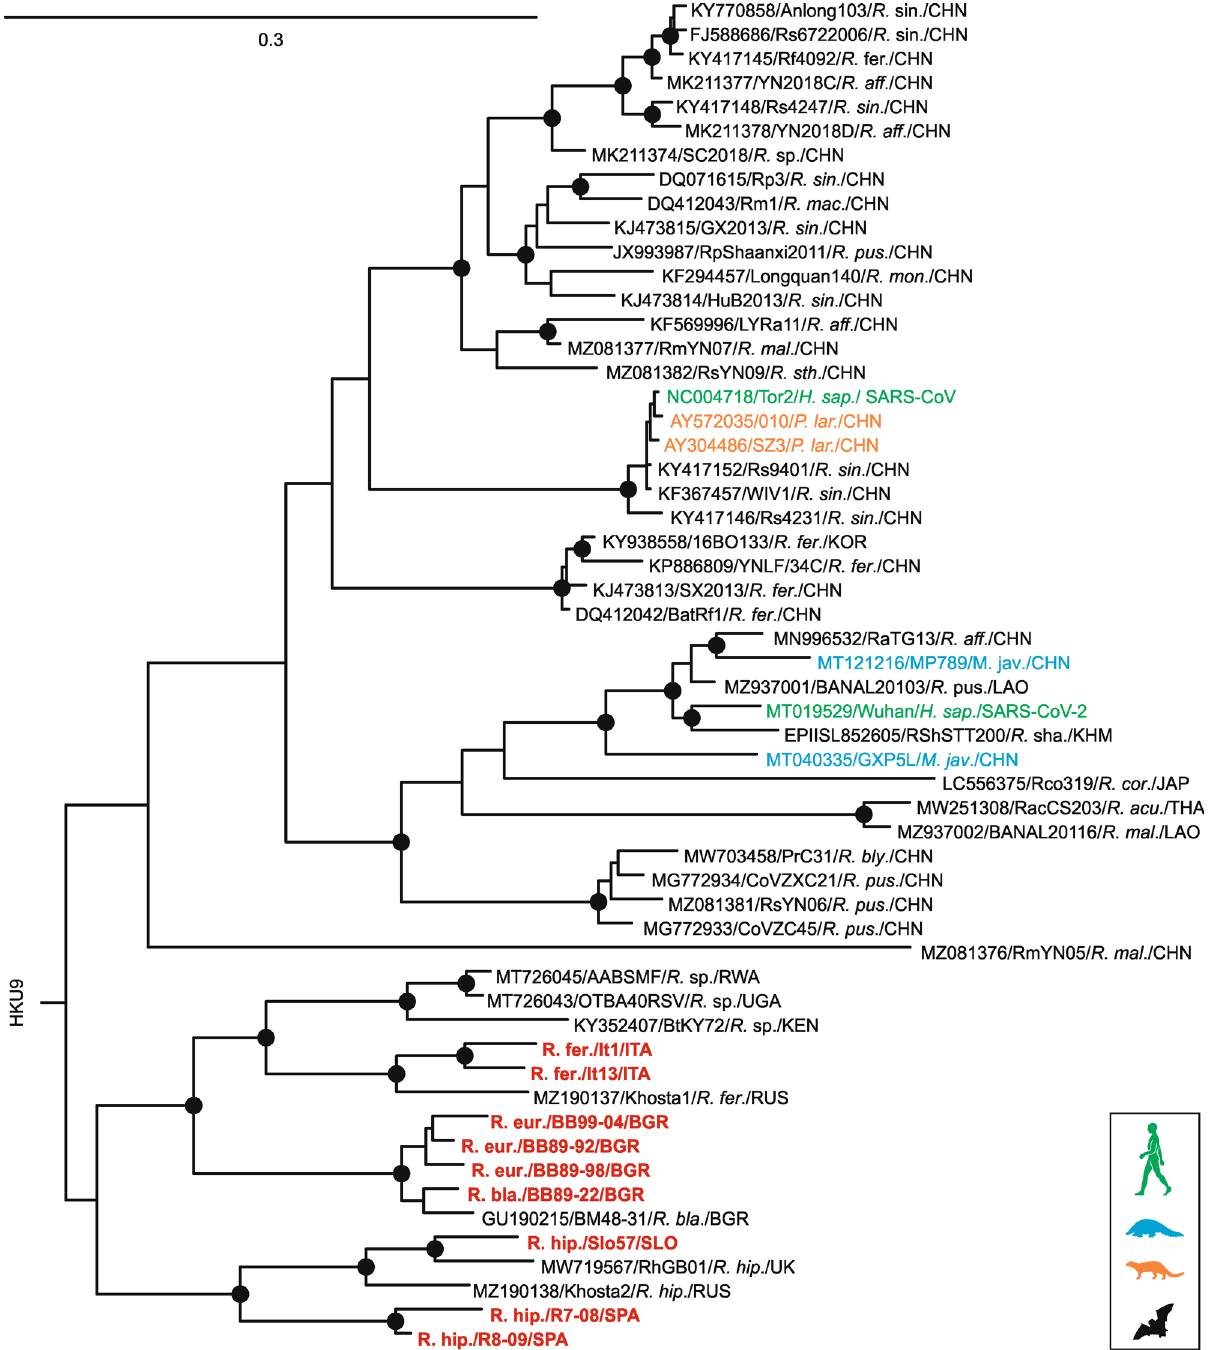
Fig. 1 Evolutionary relationships of SARS – related coronaviruses. Phylogeny based on a partial S2-fragment (495 nt) of representative sequences of the complete diversity of SARS-related coronaviruses ( SrC) shown in Supplementary Fig. 1. European horseshoe bat SrC generated within this study are shown in bold red and without accession numbers. Sequences are named as followed: GenBank accession number/strain name/host species/country of detection. Circles at nodes indicate support of grouping in ≥ 90% of 1000 bootstrap replicates. Scale bar represents nucleotide substitutions per site. H. sap ., Homo sapiens ; M. jav ., Manis javanica ; P. lar ., Paguma larvata ; R. acu ., Rhinolophus acuminatus ; R. aff ., Rhinolophus af fi nis ; R. bla ., Rhinolophus blasii ; R. bly ., Rhinolophus blythi ; R. cor ., Rhinolophus cornutus ; R. eur ., Rhinolophus euryale ; R. fer ., Rhinolophus ferrumequinum ; R. hip ., Rhinolophus hipposideros ; R. mac ., Rhinolophus macrotis ; R. mal ., Rhinolophus malayanus ; R. mon ., Rhinolophus monoceros ; R. pea ., Rhinolophus pearsonii ; R. pus ., Rhinolophus pusillus ; R. sha., Rhinolophus shameli; R. sin ., Rhinolophus sinicus ; R . sp., Rhinolophus species ; R. sth ., Rhinolophus stheno ; BGR, Bulgaria; CHN, China; ITA, Italy; JPN, Japan; KEN, Kenya; KHM, Cambodia; KOR, Korea; LAO, Laos; RUS, Russia; RWA, Ruanda; SLO, Slovenia; SPA, Spain; THA, Thailand; UGA, Uganda; UK, United Kingdom.